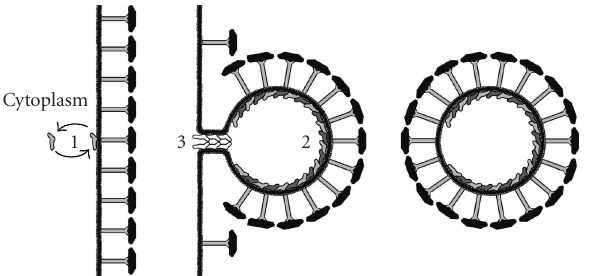
Figure 2: Model for vesicle budding in crenarchaea. Archaeal homologues of eukaryote ESCRT-III subunits are in equilibrium between a freely di ff usible state in the cytoplasm and a membrane- bound state (1). If the equilibrium shifts towards the membrane associated state a heterocomplex (2) of di ff erent ESCRT-III subunits is formed leading to the creation of an outwardly growing bud that is covered by S-layer protein. Recruitment of the last group of ECRT-III subunits (3) creates the “neck” through which the bud is attached to the cytoplasmic membrane just before the membrane vesicle is pinched o ff and released into the